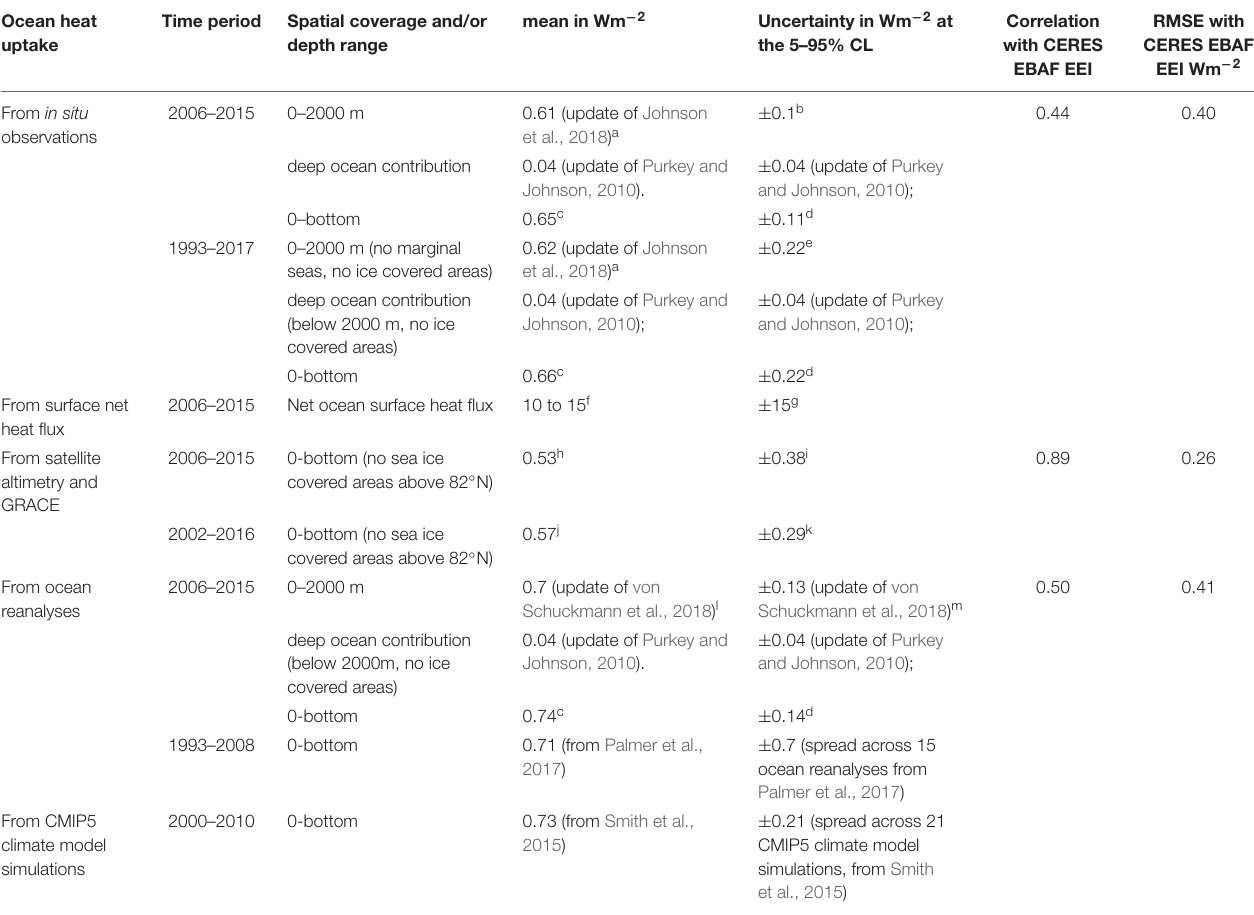
TABLE 3 | Ocean heat uptake and associated uncertainty as estimated with the different methods listed in this paper. The correlation and the RMSE with the TOA radiative budget estimate of the EEI from CERES EBAF is given in column 6 and 7. CERES EBAF values taken from Johnson et al. (2016). All with respect to global